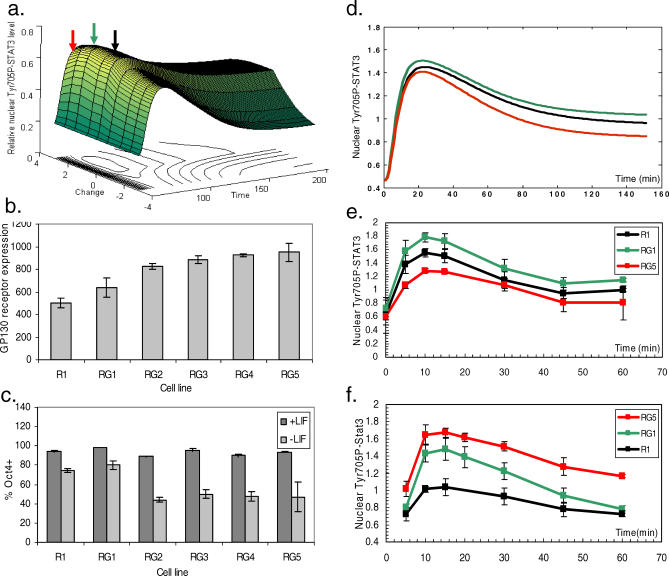
GP130 Overexpressing Cell Lines Show Non-Monotonic Response of Stat3 Activation to Receptor Overexpression(A) The model-predicted surface of Stat3 activation is shown as a function of time and change in production of GP130 receptors. Successive increase in GP130 production as shown by black, green, and red arrows in that order shows a non-monotonic response of Stat3 activation and the presence of a local maximum. This is illustrated by the circle in the contour map on the x–y plane.(B) GP130 overexpressing cell lines RG1–RG5 were developed to express the receptor at varying levels compared with R1 cells, and these cell lines retain Oct4 expression in the presence of LIF (C).(D) Model-predicted trends of GP130 overexpression corresponding to (A) shows normal profile of Stat3 activation (black line), Stat3 activation in slight GP130 overexpression (green line), and significant GP130 overexpression (red line).(E) Experimental results show a consistent trend in LIF-induced Stat3 activation profile using RG1 and RG5 cell lines in comparison with model results in (D).(F) IL-6 stimulation of GP130 overexpressing cell lines shows a dose-dependent increase in Stat3 activation as a function of GP130 overexpression.